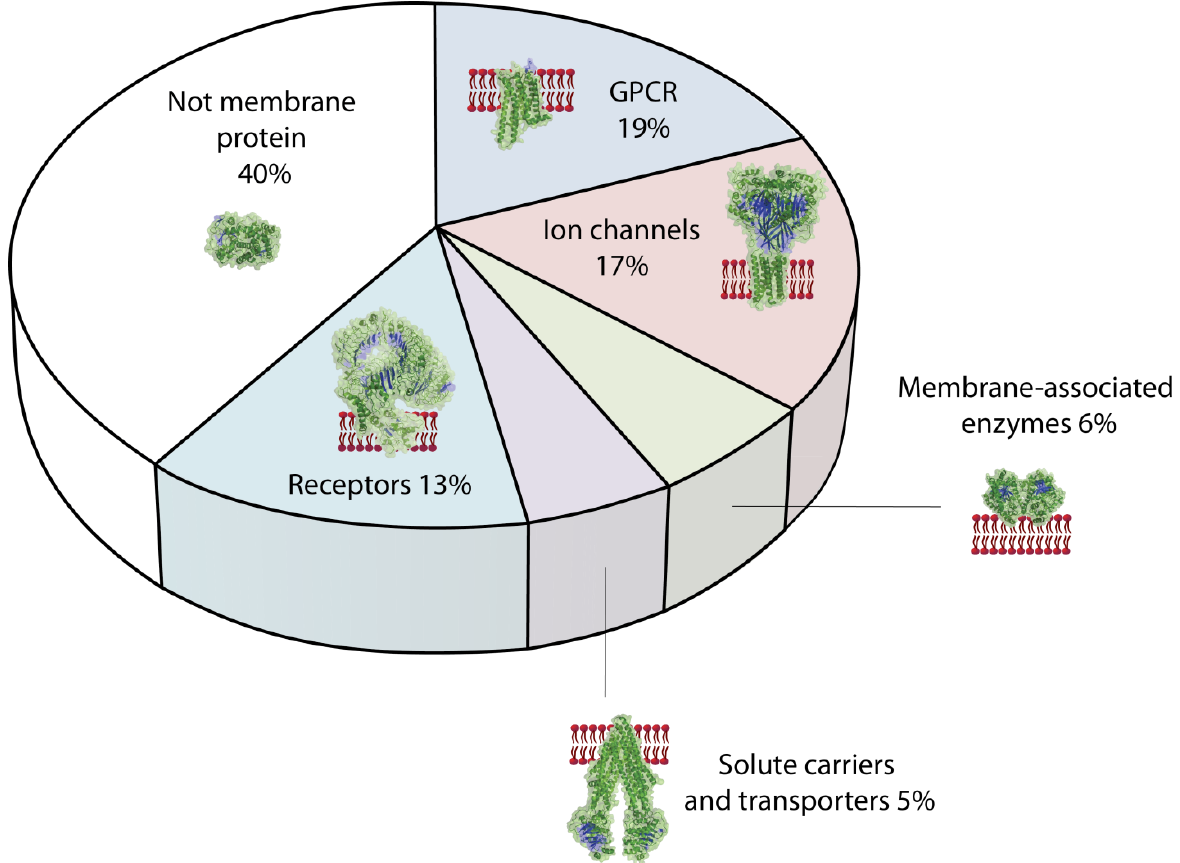
Figure 5. Human membrane proteins as drug